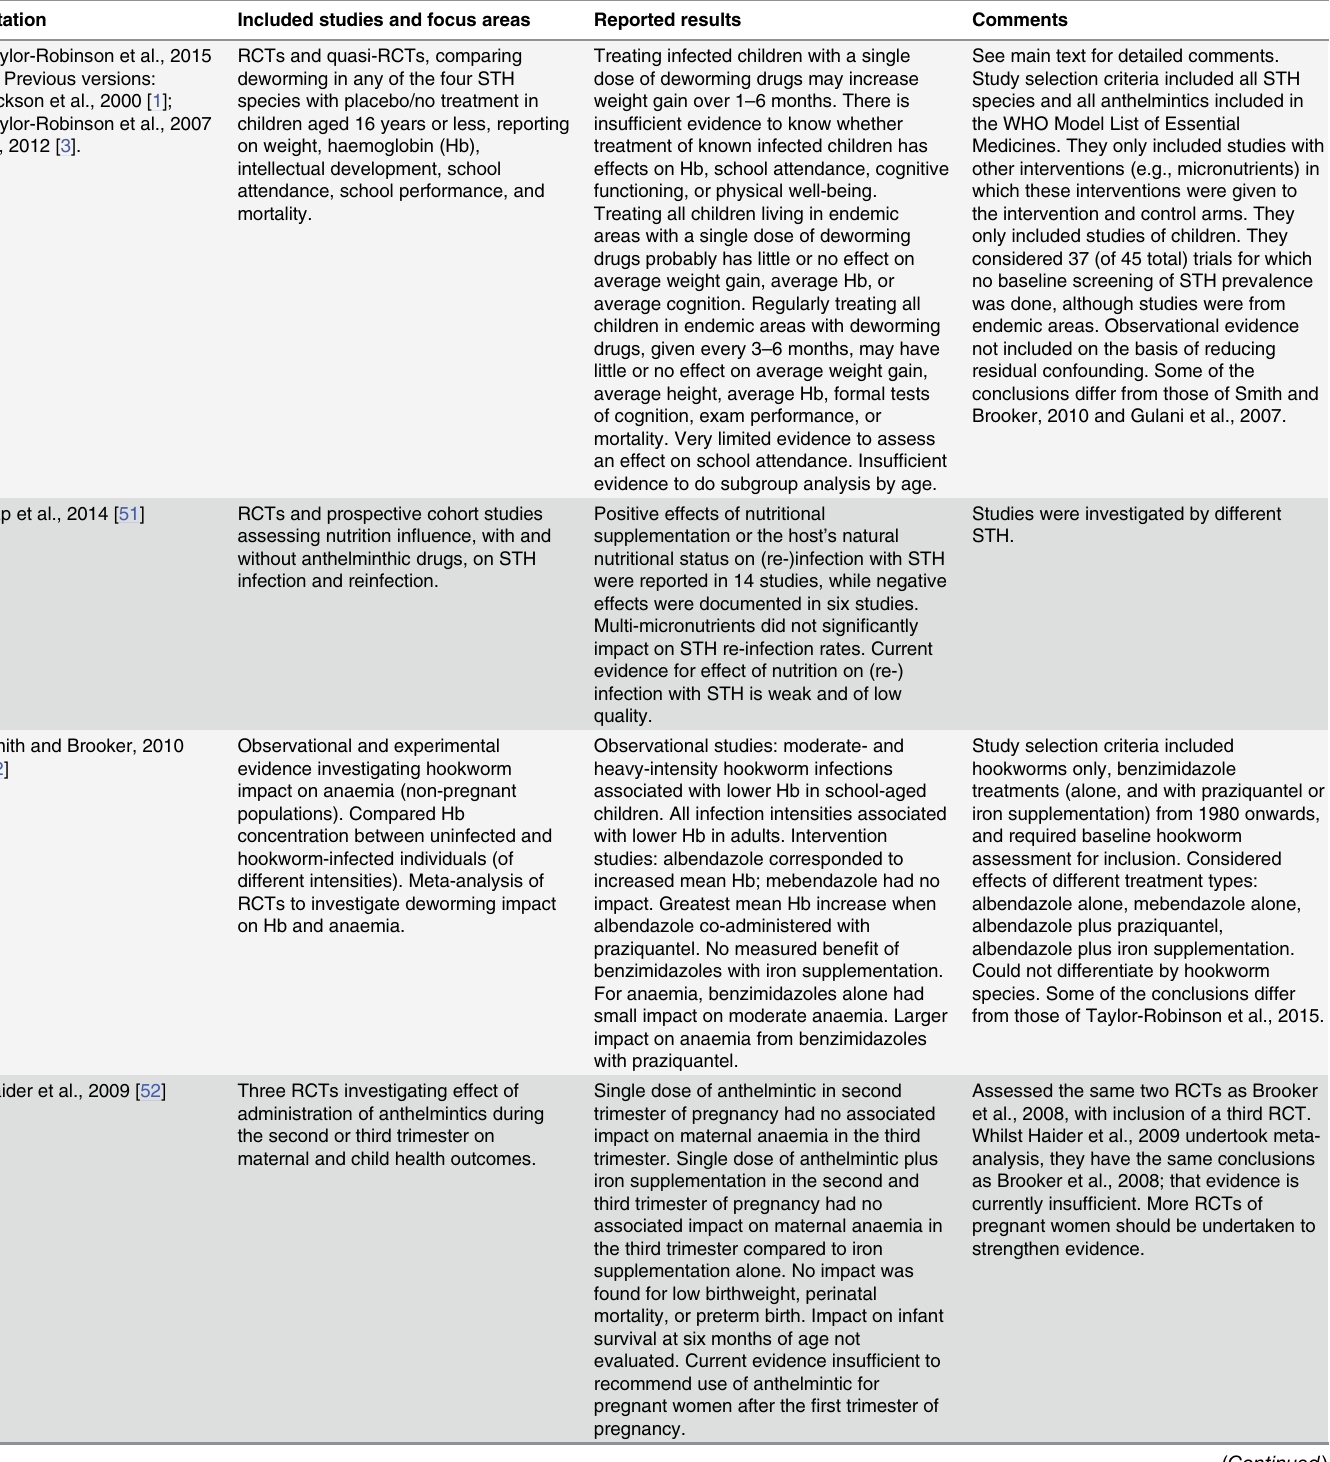
Table 2. Evidence from systematic reviews of soil-transmitted helminth morbidity published since 2000 (selected according to specified criteria, arranged by date of most to least recent).